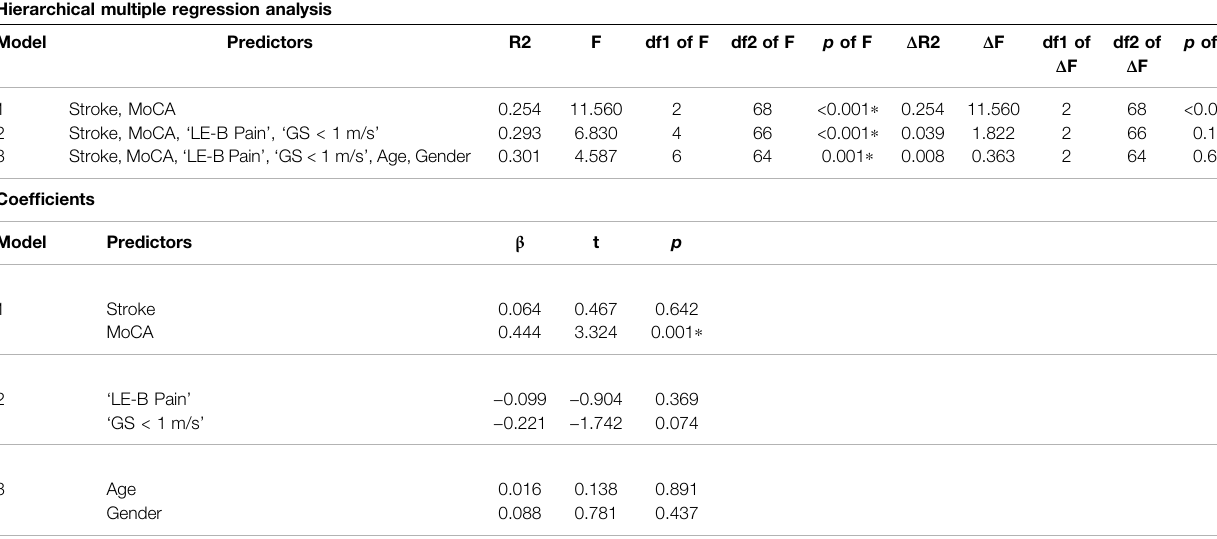
TABLE 4 | Predictors of an altered Walk